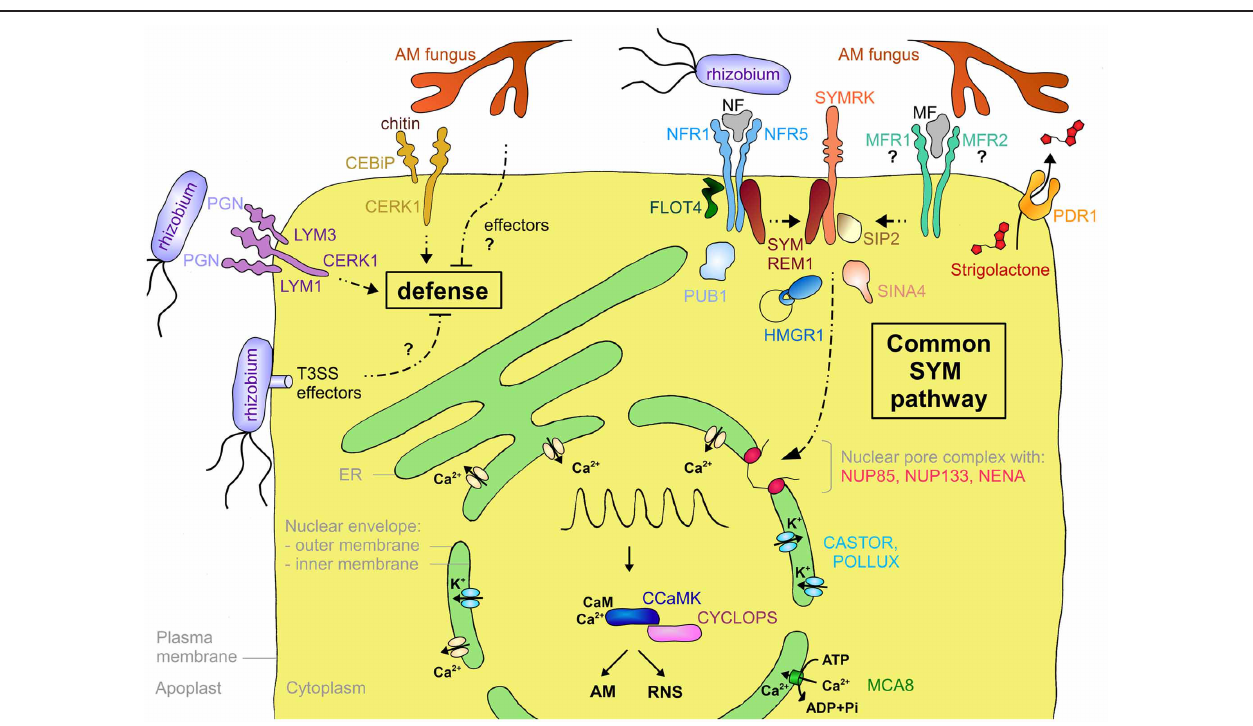
from L. japonicus , whereas the elusive nature of the myc factor receptors (MFR1 and MFR2) is shown with question marks. The common SYM pathway is represented by SYMRK, NENA, NUP85, NUP133, CASTOR, POLLUX, CCAMK, and CYCLOPS from L. japonicus . The remaining components (MCA8, SIP2, FLOT4, PUB1, SYMREM1, SINA4, and HMGR1) were described in M. truncatula or L. japonicus , except for PDR1 that was discovered in petunia. See Table A1 and the main text for more information on the respective genes and their function in